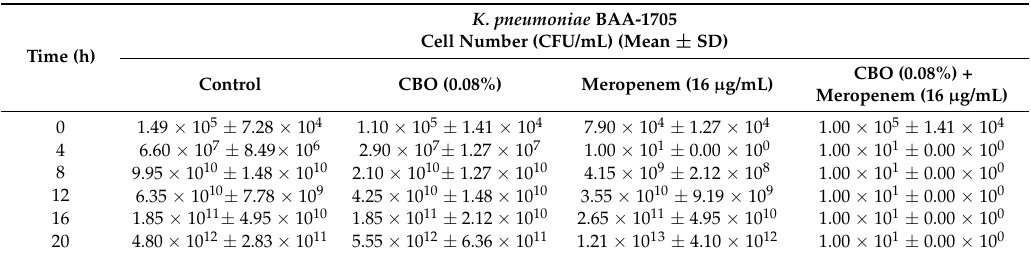
Table A1. Raw data of time kill analysis at 4 h interval for 20 h.